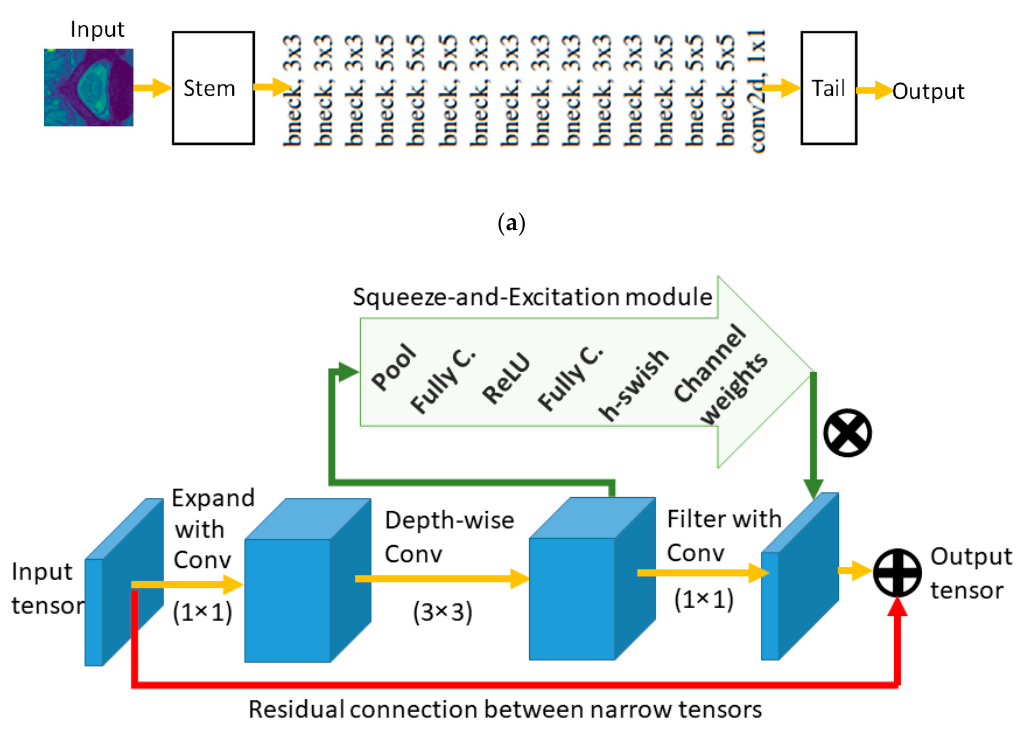
Figure 8. MobileNet models are composed of a concatenated set of bneck blocks. ( a ) High level overview. ( b ) Illustration of a bneck block.